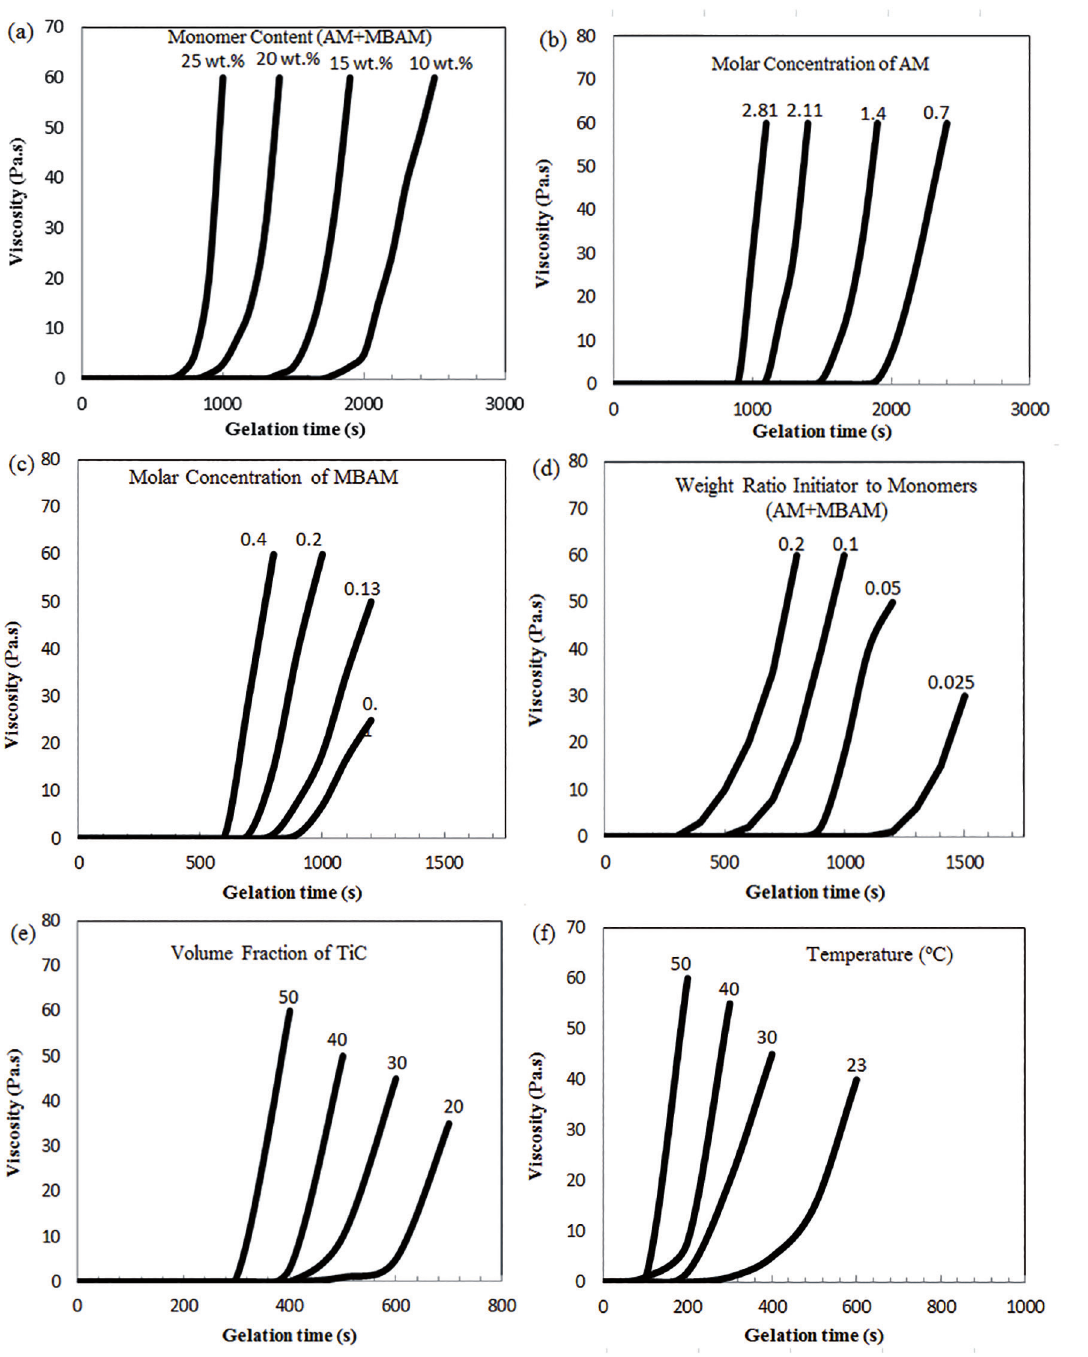
Figure 9: The changes in the viscosity of the pre-mix solution as the function of (a) monomer content, (b) molar concentration of AM, (c) molar concentration of MBAM, (d) weight ratio initiator to monomers (AM+MBAM), (e) volume fraction of TiC and (f) temperature.